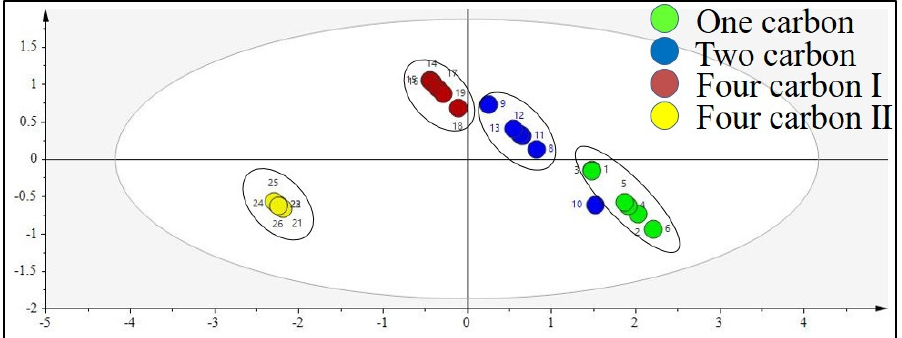
Figure 3. Partial least squares discriminant analysis (PLS-DA) of carbon chain length on HepG2 (human hepatocellular carcinoma). Four carbon I—a carbon chain of four carbon atoms and pyrazine were combined at the C-28 position; Four carbon II—a carbon chain of four carbon atoms was added at the C-28 position, but pyrazine was added at the C-23 position.